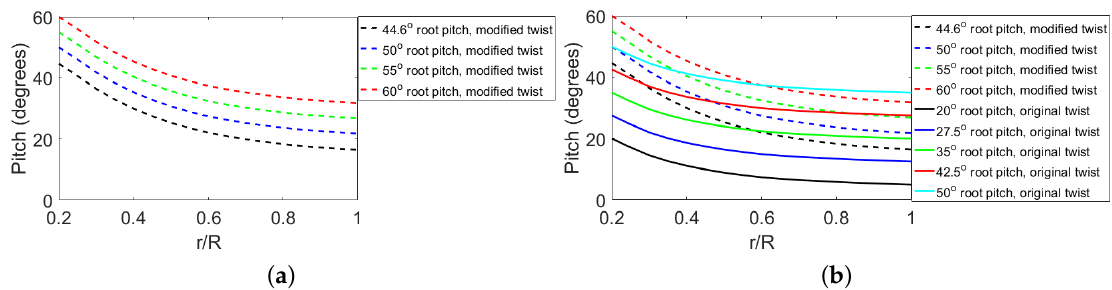
Figure A4. Pitch distribution for the original blade at different root pitch angles and for the design twist blade at different root pitch angles. ( a ) Design twist; ( b ) all